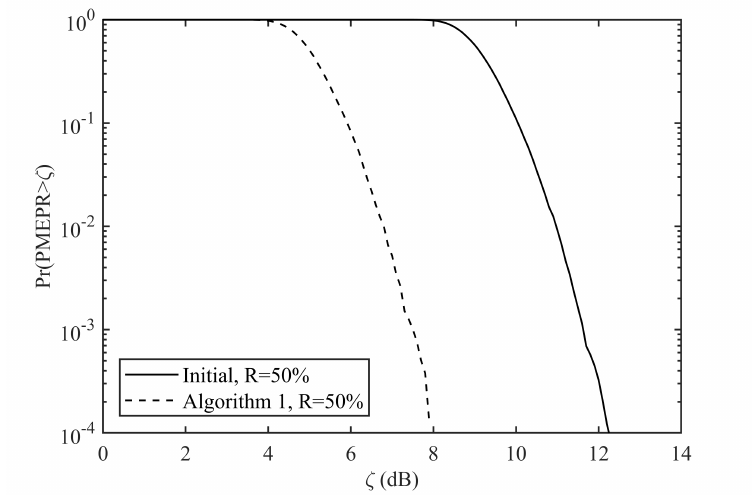
Figure 1. CCDFs of PMEPRs for random informative symbols, where Algorithm 1 is from